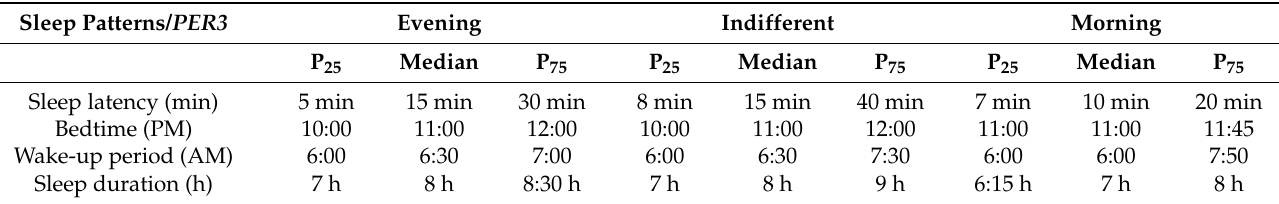
Table 1. Sleep patterns according to PER 3 VNTR polymorphism.